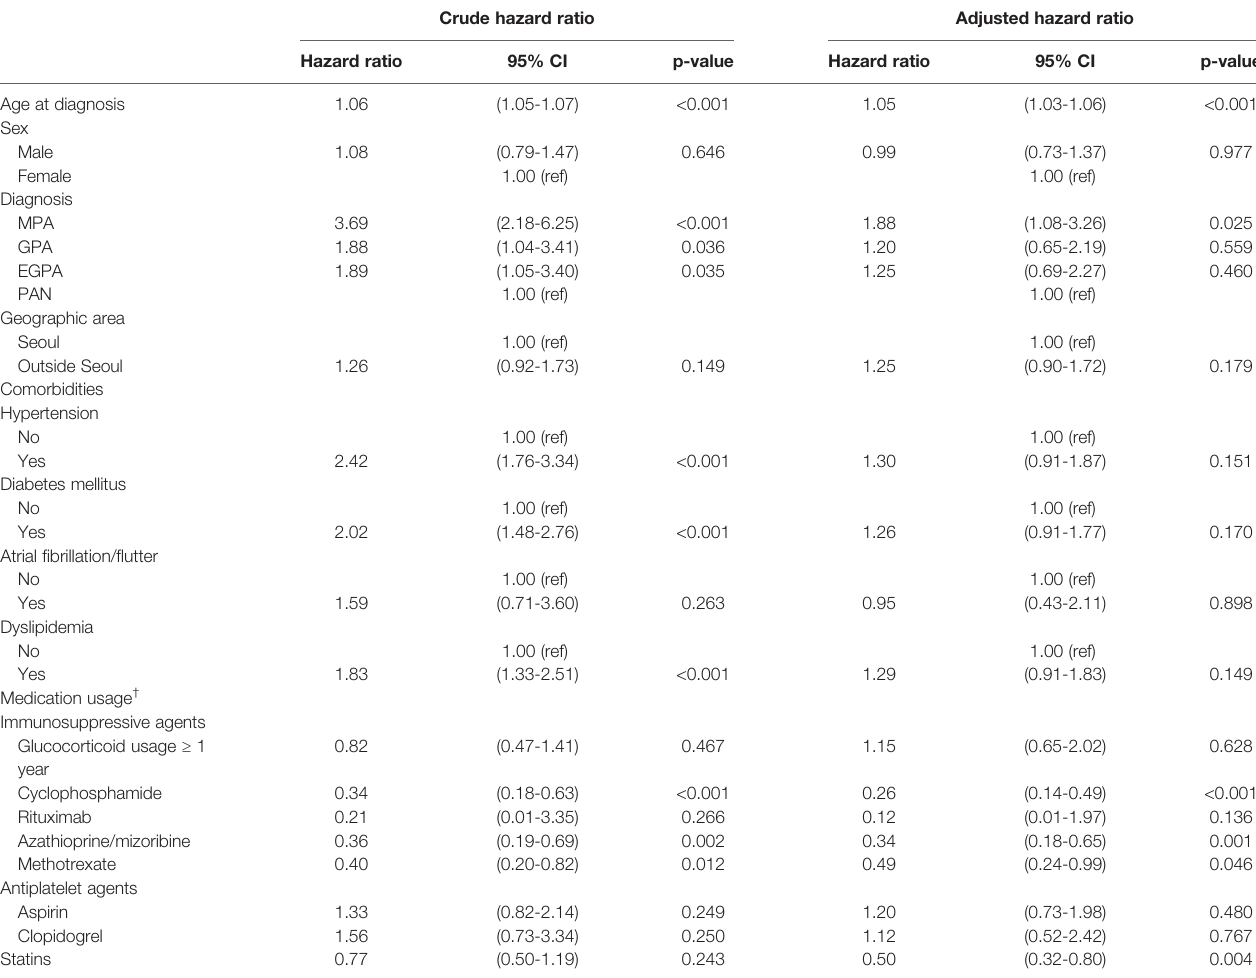
TABLE 3 | Factors associated with the risk of stroke in SNV